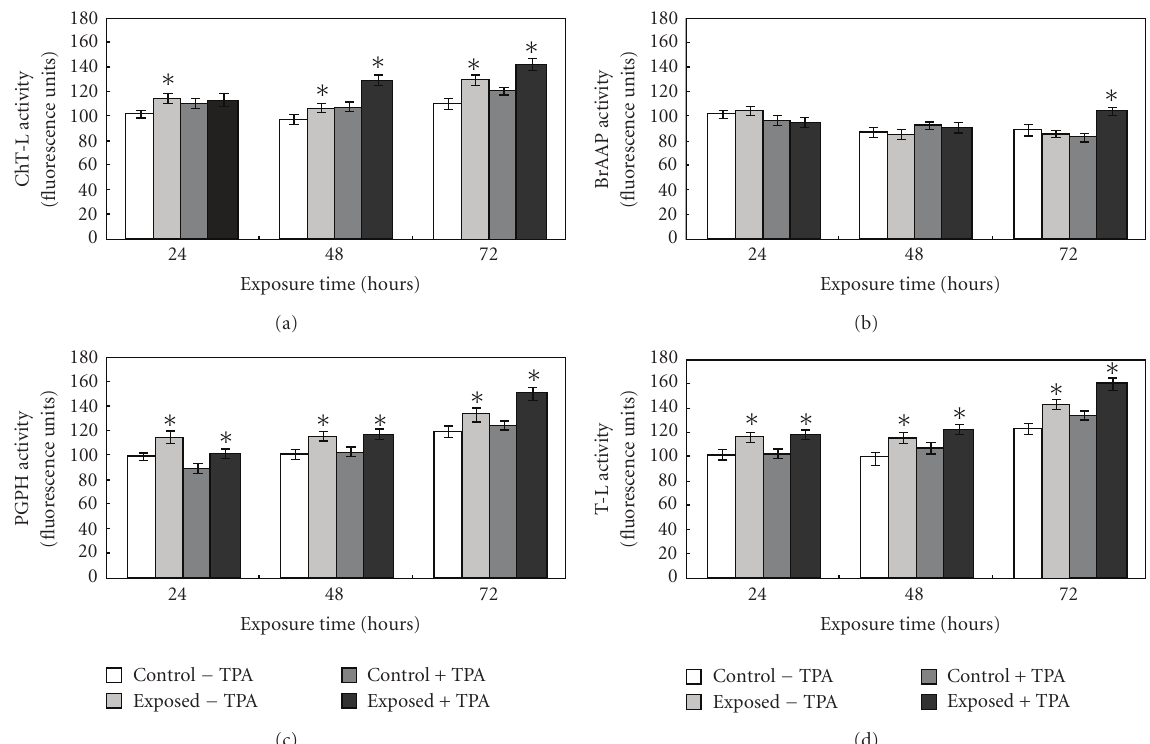
Figure 5: Proteasomal activities measured in cell lysates upon exposure to ELF-EMFs. Caco cells were treated or not with 0.1 μ M TPA for 24, 48, and 72 hours; they were exposed to ELF-EMFs while the control dishes were placed under the same conditions in a solenoid with no field. After harvesting and lysing the cells, ChT-L (suc-Leu-Leu-Val-Tyr-AMC), T-L (Z-Leu-Ser-Thr-Arg-AMC) PGPH (Z-Leu-Leu-Glu-AMC), and BrAAP (Z-Gly-Pro-Ala-Leu-Ala-pAB) activities were executed in the cell extracts. Data are expressed as fluorescence arbitrary units subtracted of the values of control assays in the presence of specific inhibitors. Data are mean ± SE of six separate experiments. Asterisks represent statistically significant di ff erences from the respective control, not exposed, cultures: P < . 05.